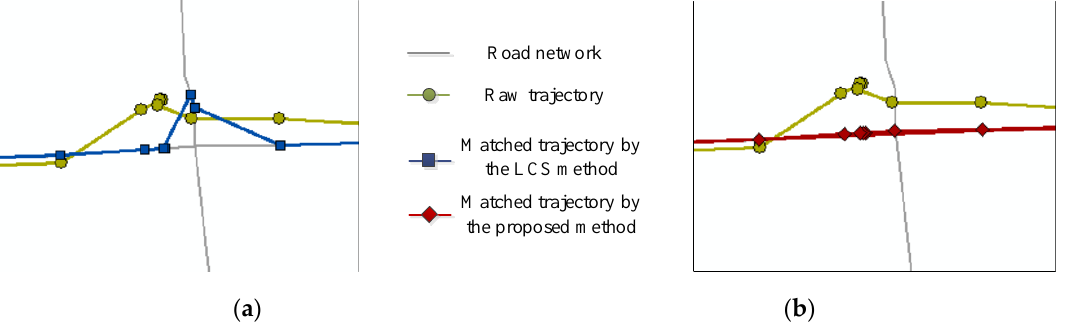
Figure 7. Comparison of matching results: ( a ) The LCS method, and ( b ) the proposed method.